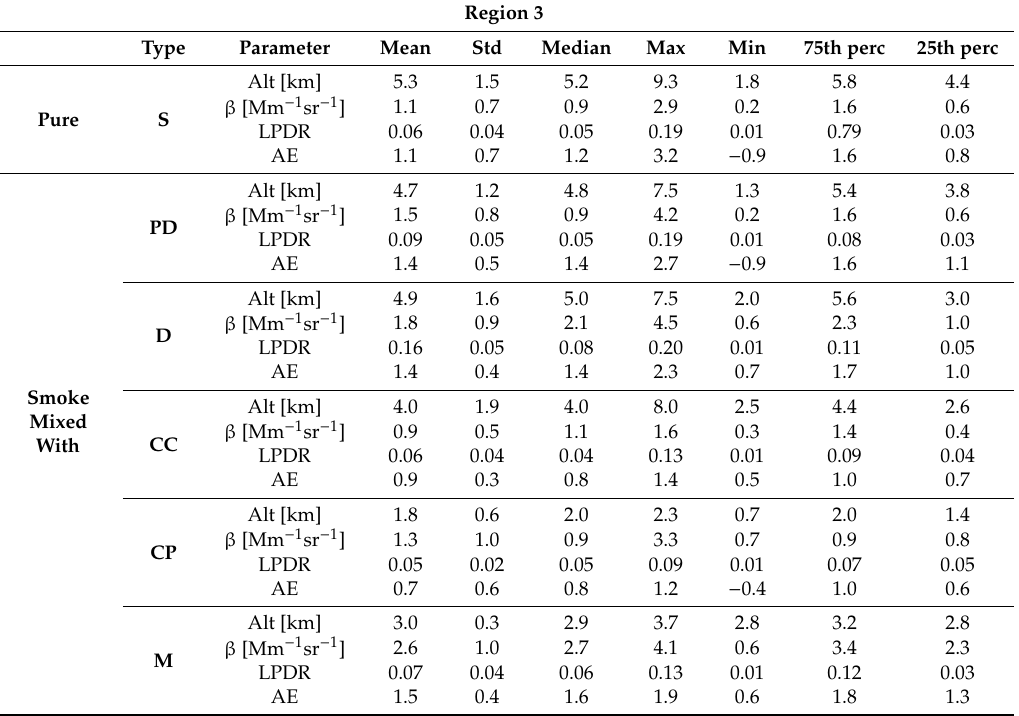
Table A3. Descriptive Statistics for di ff erent aerosol types for Region 3 (R3): mean, standard deviation (std), median, maximum value (max), minimum value (min), 75th and 25th percentile for all variables.